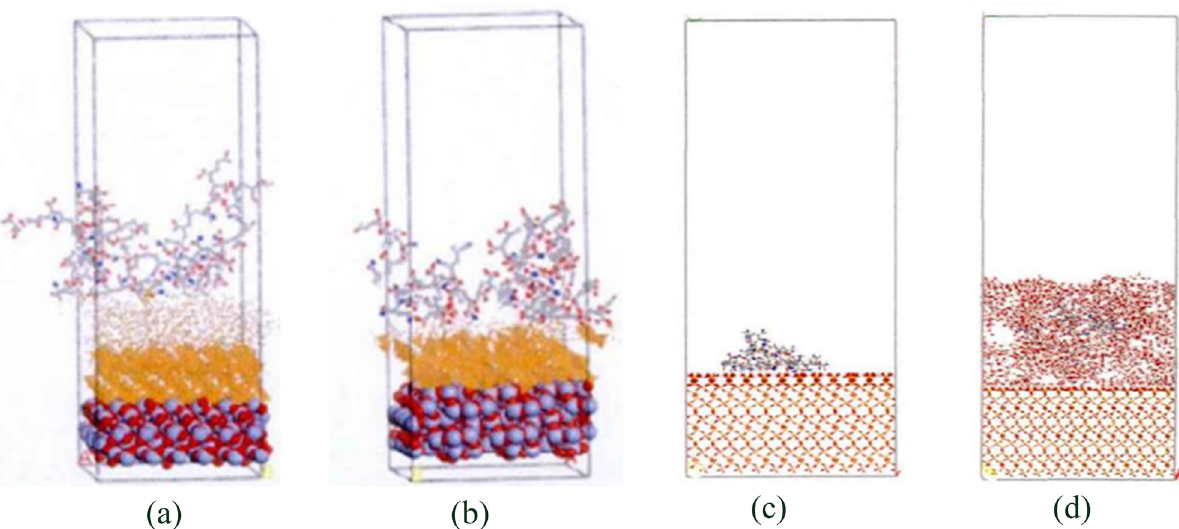
Figure 12: ( a ) Octyltrimethoxysilane - modi fi ed silica and acrylic – acrylamide copolymer layered model [ 248 ] , ( b ) vinyltrimethoxysilane - modi fi ed silica and acrylic – acrylamide copolymer layered model [ 248 ] , ( c ) PAM/SiO 2 interface model [ 249 ] , and ( d ) PAM/H 2 O/SiO 2 interface model [ 249 ]